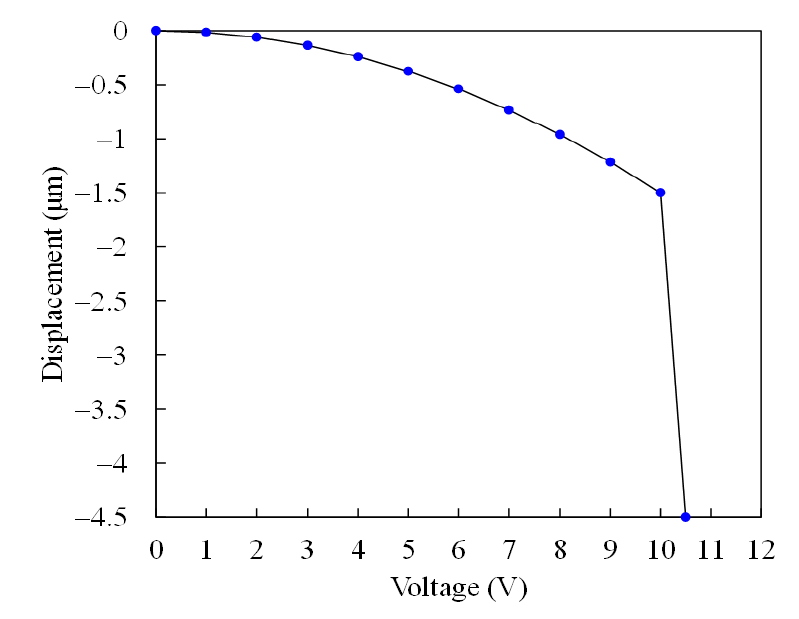
Figure 4. Membrane displacement vs. actuation voltage.